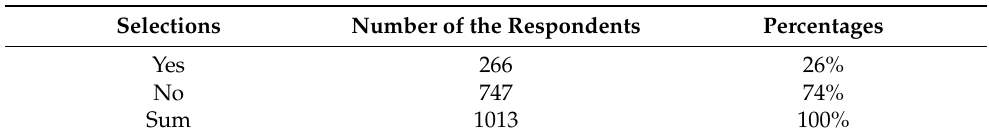
Table A13. Are the current IFRS standards satisfied holdings of cryptocurrencies (single-choice question)?